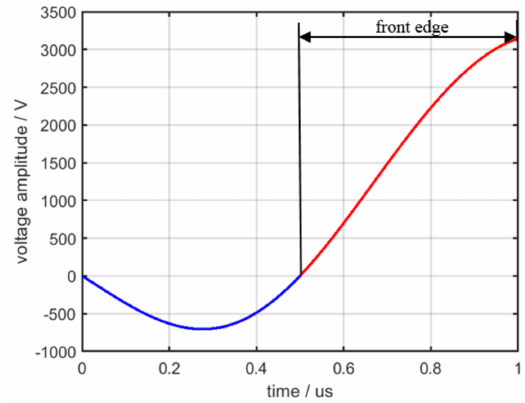
Figure 15. Front edge of the simulation modulation